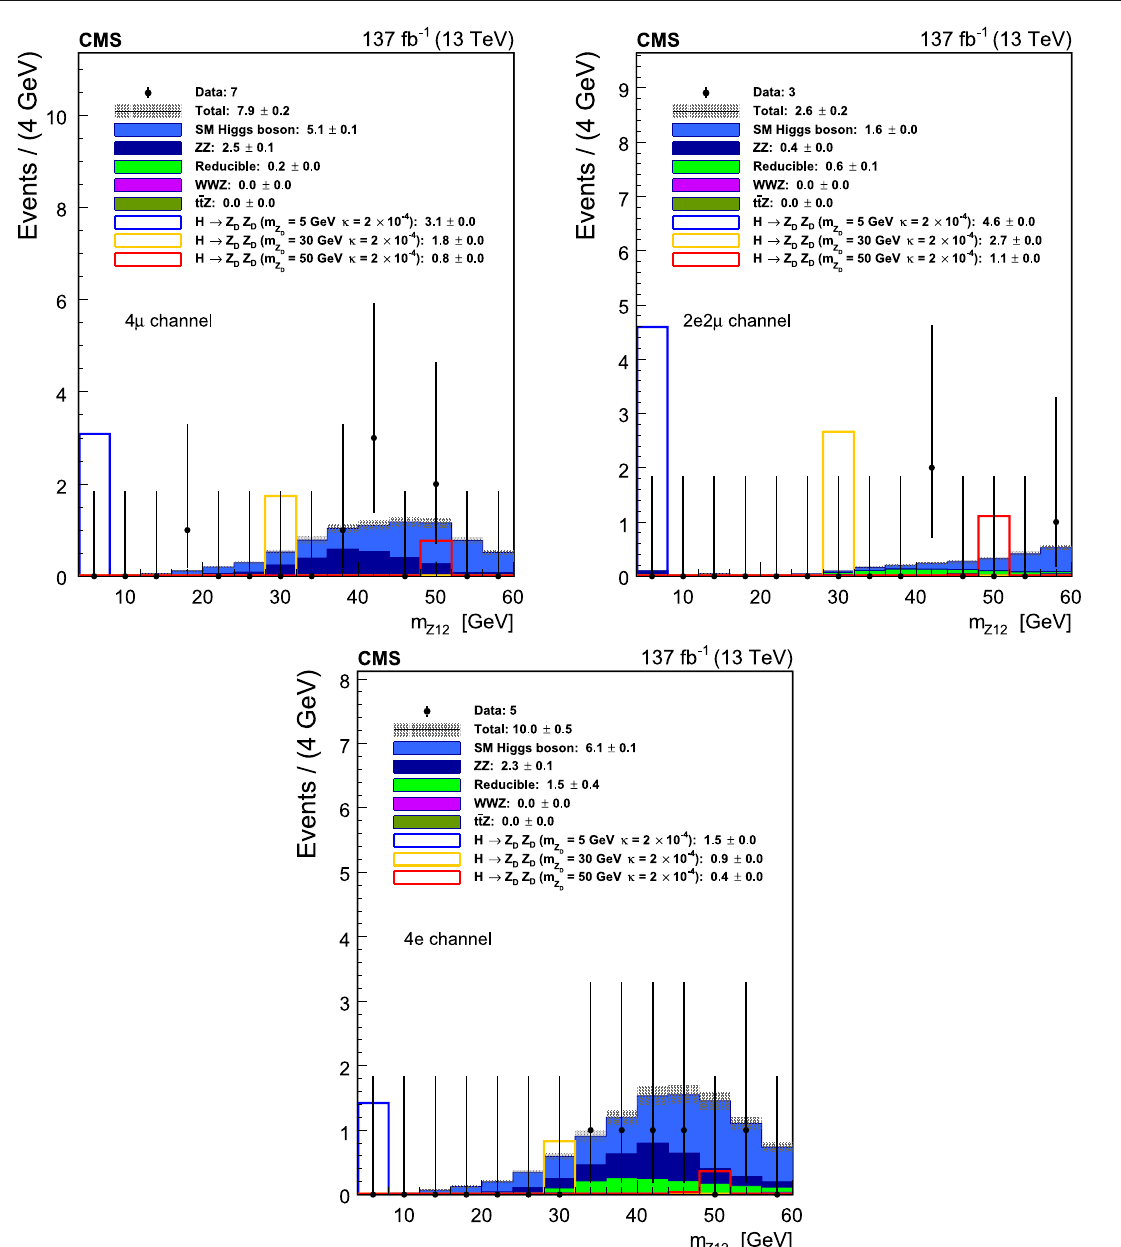
+ m )/ 2withtheXX selec- the expected yields for each background and signal processes, along Z 2 1 with the corresponding statistical uncertainty coming from the amount of simulated data